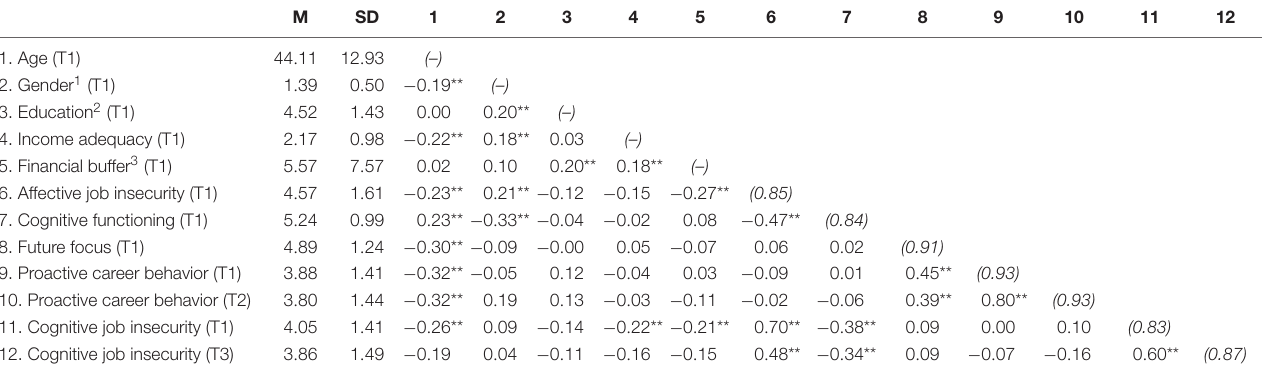
TABLE 1 | Means, Standard Deviations, Internal Consistencies, and Correlations.